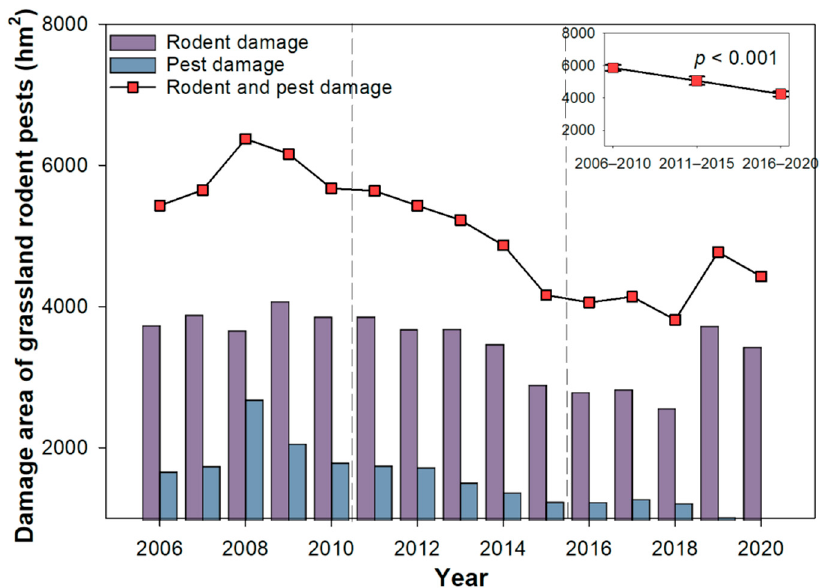
Figure 3. The areas damaged by rodents and pests in the grasslands of China from 2006 to 2020.